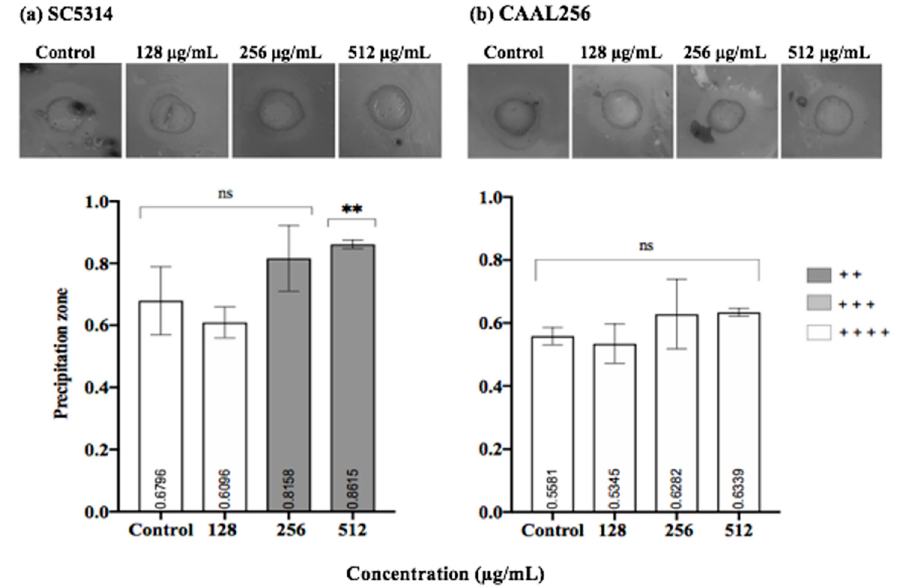
Figure 7. Proteinase production by C. albicans ( a ) SC5314 and ( b ) CAAL256 strains. Pz classification: